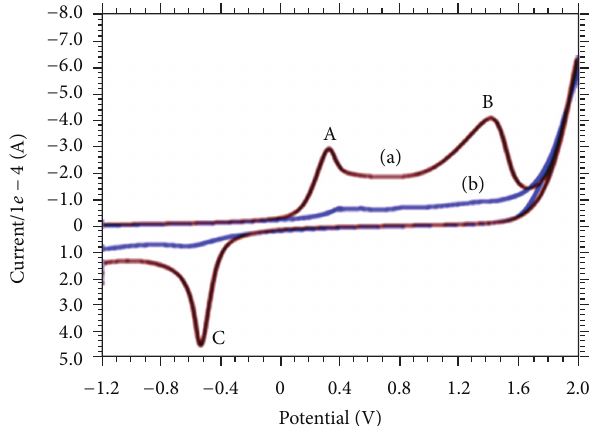
Figure 1: Cyclic voltammogram obtained for 1mM 2-thiouracil on glassy carbon electrode in pH 4.2, 0.2 M buffer: (a) 2-thiouracil and (b) blank run without 2-thiouracil at 𝜐 = 50 mVs −1 (A and B are oxidation peaks whereas C is reduction peak).